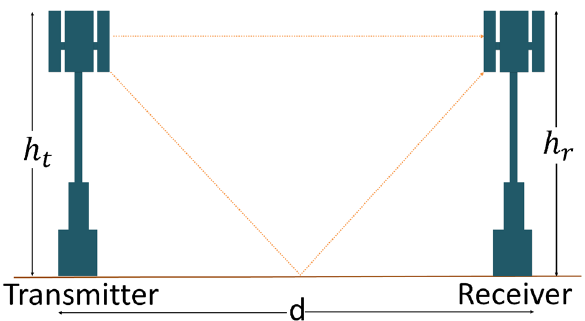
Figure 2. Two ray ground propagation model.